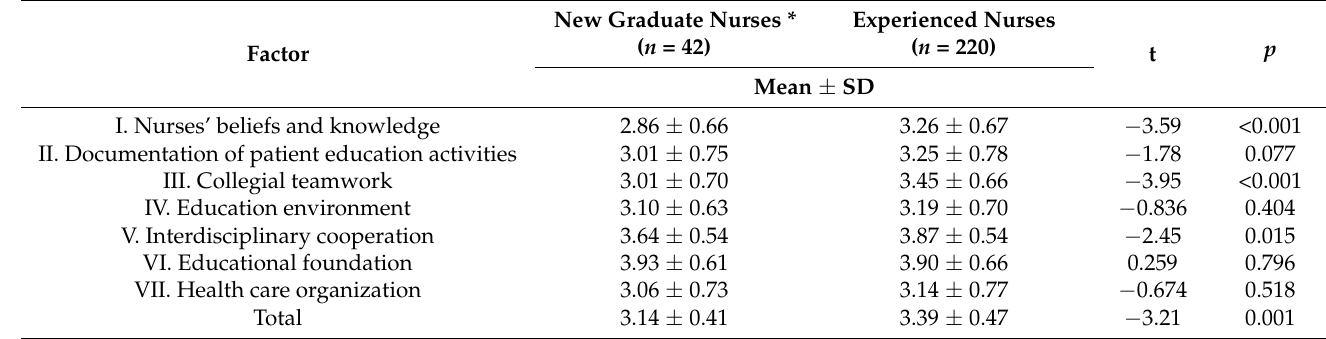
Table 3. Comparison of Scores between New Graduate and Experienced